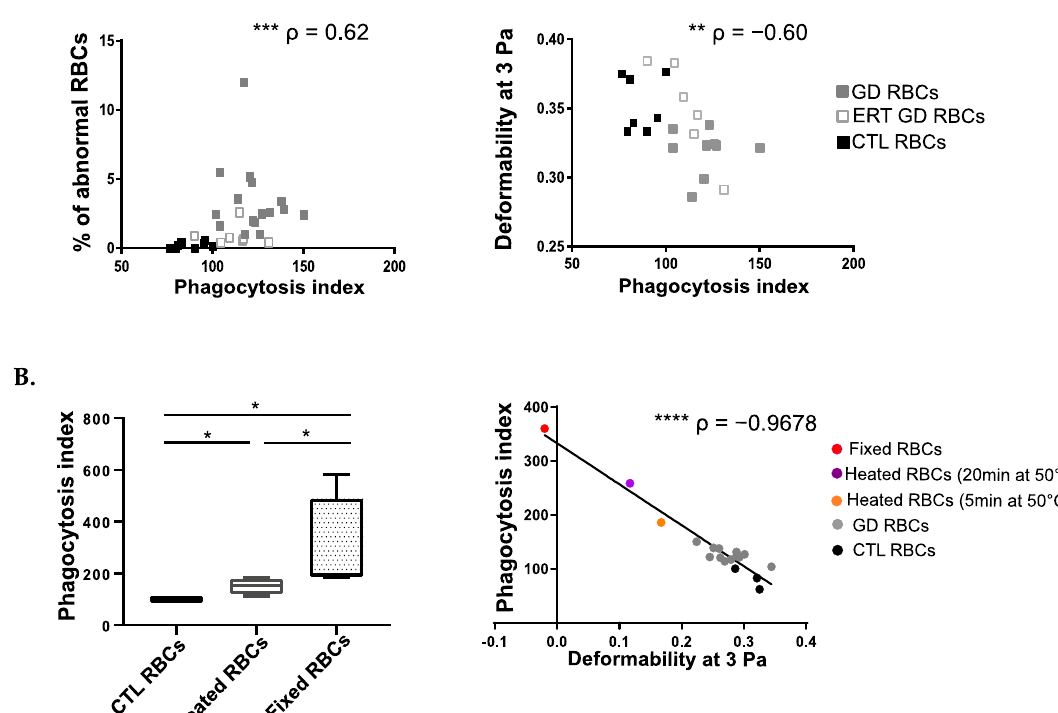
Figure 2. The uptake of GD RBCs correlates with cell deformability and morphology. ( A ) Left panel: Positive correlation between the PI and the percentage of abnormal morphologies of RBCs. Right panel: Negative correlation between the PI and the deformability of RBCs at 3 Pa. GD, ERT GD, and CTL RBCs values are depicted with gray, white and dark squares, respectively. The p and ρ values were determined using the Spearman rank correlation test. ** p < 0.01; *** p < 0.001. ( B ) Left panel: Erythrophagocytosis assays were performed using THP1-derived macrophages co-incubated with untreated CTL RBCs ( n = 4) or CTL RBCs ( n = 4) artificially made less deformable after heating for 20 min at 50 °C or after fixation with glutaraldehyde at 0.025% ( n = 4). The chart represents the PI. The medians are represented as horizontal bars; the upper and lower quartiles are represented as the top and the bottom of the box, respectively; and the maximum and minimum data values are shown by dashes at the top and the bottom, respectively, of the whiskers. Group comparison 2 by 2 was performed using a Mann-Whitney test. * p < 0.05. Right panel: Negative correlation between the PI and the deformability of RBCs at 3 Pa ( n = 19). CTL RBCs, GD RBCs, and CTL RBCs artificially made less deformable after heating for 5 min or for 20 min at 50 °C or after fixation with glutaraldehyde were used. The p and ρ values were determined using the Pearson correlation test. **** p < 0.0001.